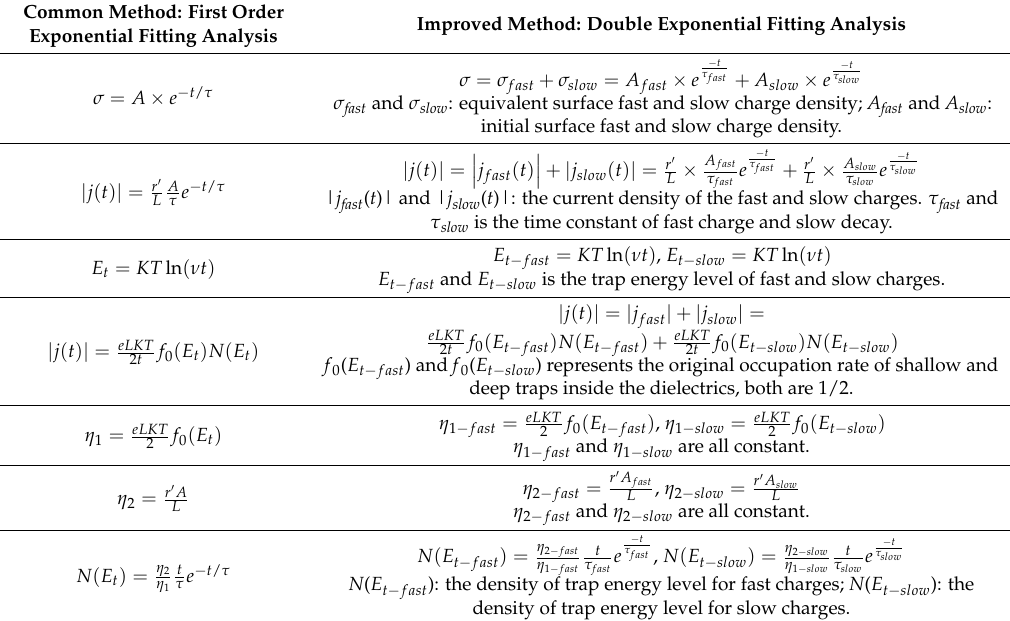
Table 1. The calculation equation of the trap distribution using common method and the improved method.